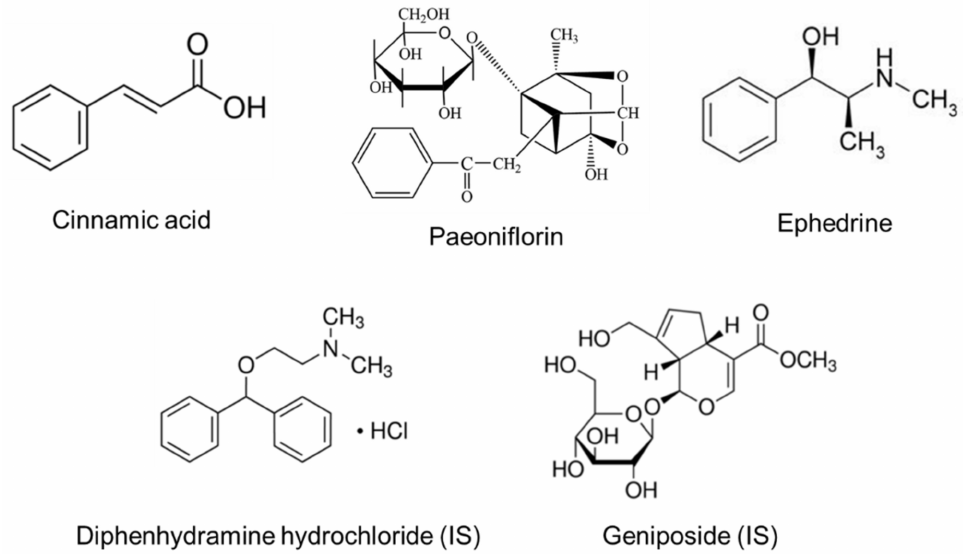
Figure 1. Chemical structures of cinnamic acid, paeoniflorin, and ephedrine as analytes and diphen- hydramine hydrochloride and geniposide as internal standards